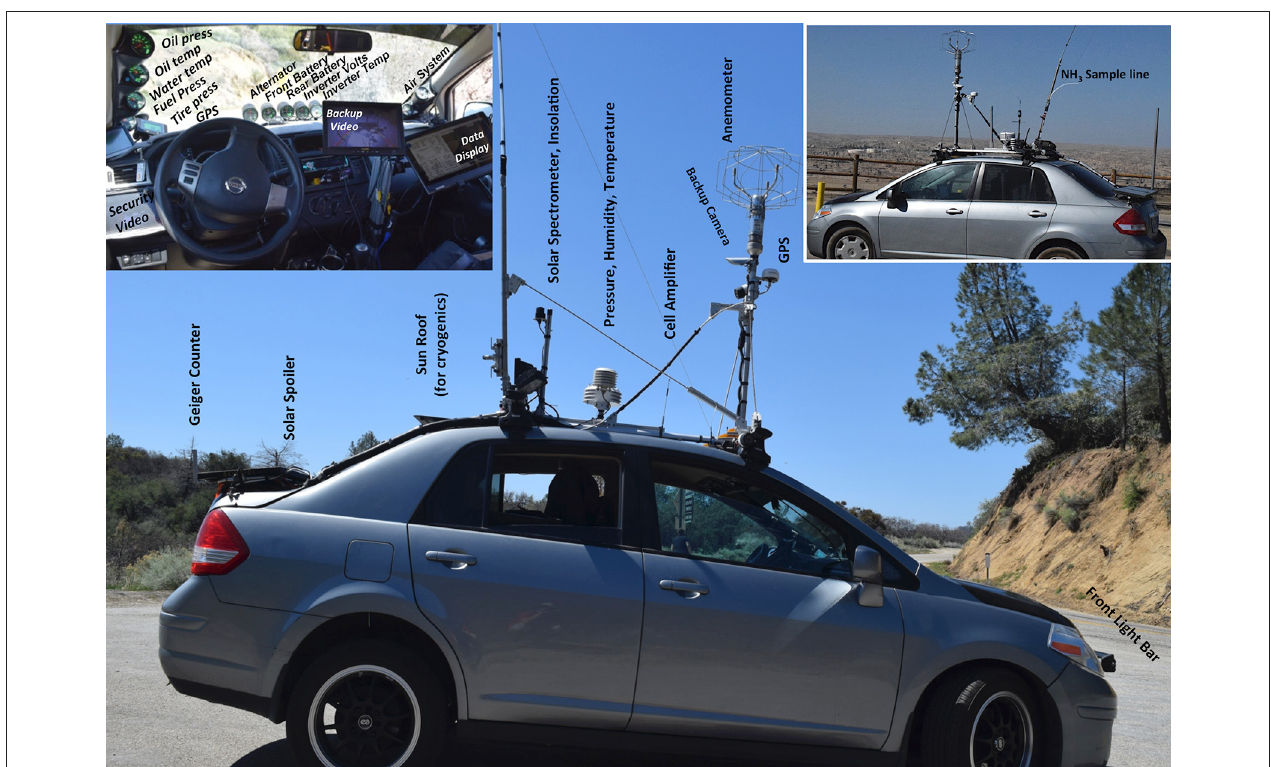
FIGURE 1 | Photos of AMOG (AutoMObile trace Gas) Surveyor. Upper left inset shows